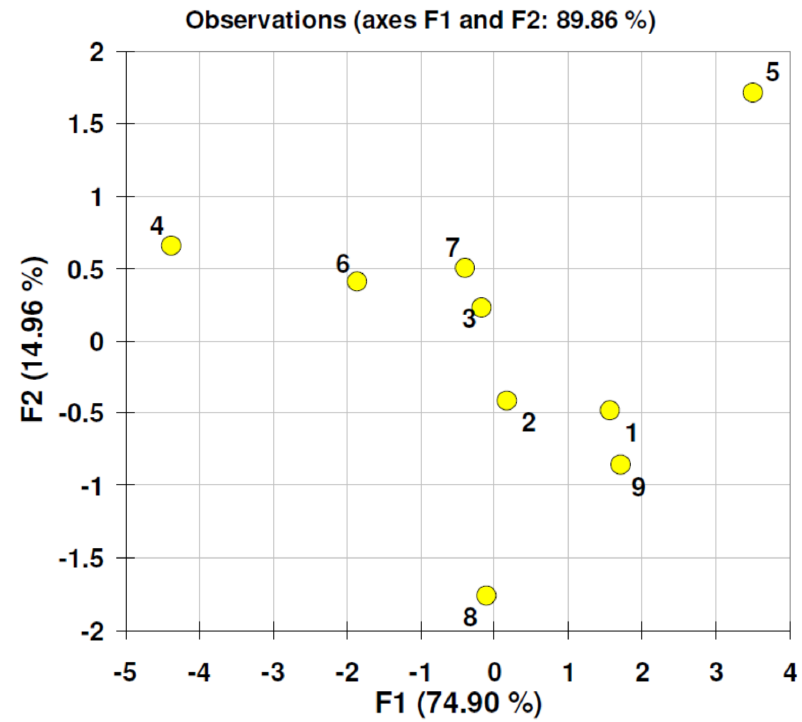
Figure 6. Factor scores plot (principal component analysis) related to 16 day experiment and calcu- lated from data matrix consisting of Brilliant Blue concentrations at different times of experiment duration (variables) and different additives (objects) listed in Table 3. Object labels: water BLANK (1), duckweed water plant DW (2), DW and graphene oxide GO (3), DW and β-cyclodextrin CD (4), DW and raw dandelion pappus DP (5), DW and microcrystalline cellulose MC (6), DW and raw pine pollen PP (7), DW and Egyptian Blue mineral pigments EB1 (8), DW and Egyptian Blue mineral pigments EB2 (9).